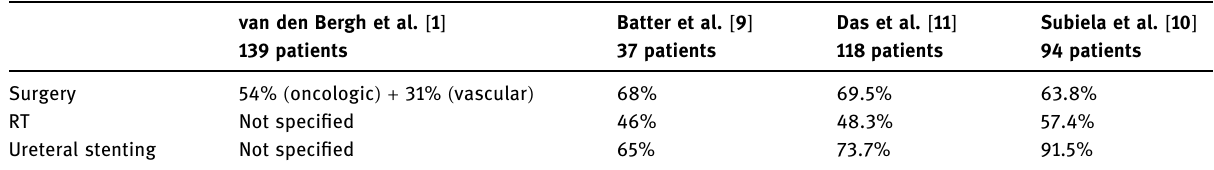
Table 2: Main risk factors reported to be associated with UAF